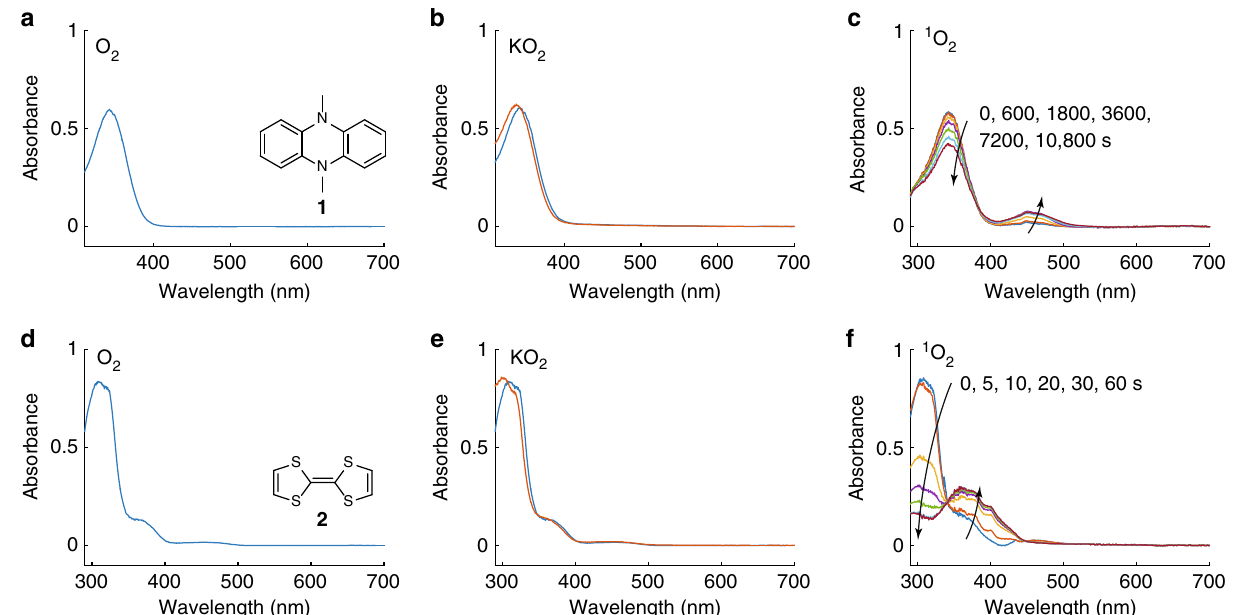
Fig. 1 Stability of reduced redox mediators against oxygen species. UV – Vis spectra of DMPZ ( a – c ) and TTF ( d – f ) in 0.1 M LiTFSI/TEGDME electrolyte before and after exposure to O 2 ( a , d ), KO 2 ( b , e ), and 1 O 2 ( c , f ). The concentrations of DMPZ and TTF were 60 µ M each in their respective solutions. O 2 and KO 2 (together with an excess of 18-crown-6) were kept in contact with the RMs for 24 h. 1 O 2 was photogenerated in the O 2 -saturated solution using 1 µ M palladium(II) meso -tetra(4- fl uorophenyl)-tetrabenzoporphyrin and illumination at 643 nm, and the spectra were measured after the illumination times indicated. The spectrum of the sensitizer has been subtracted from c and